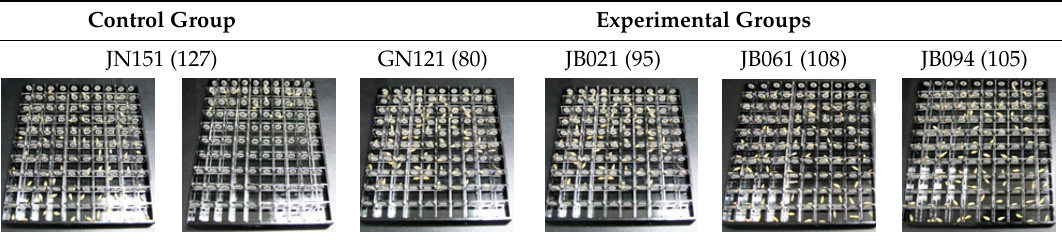
Table 2. Hulled barley samples separated by kernel into grid boxes according to groups.